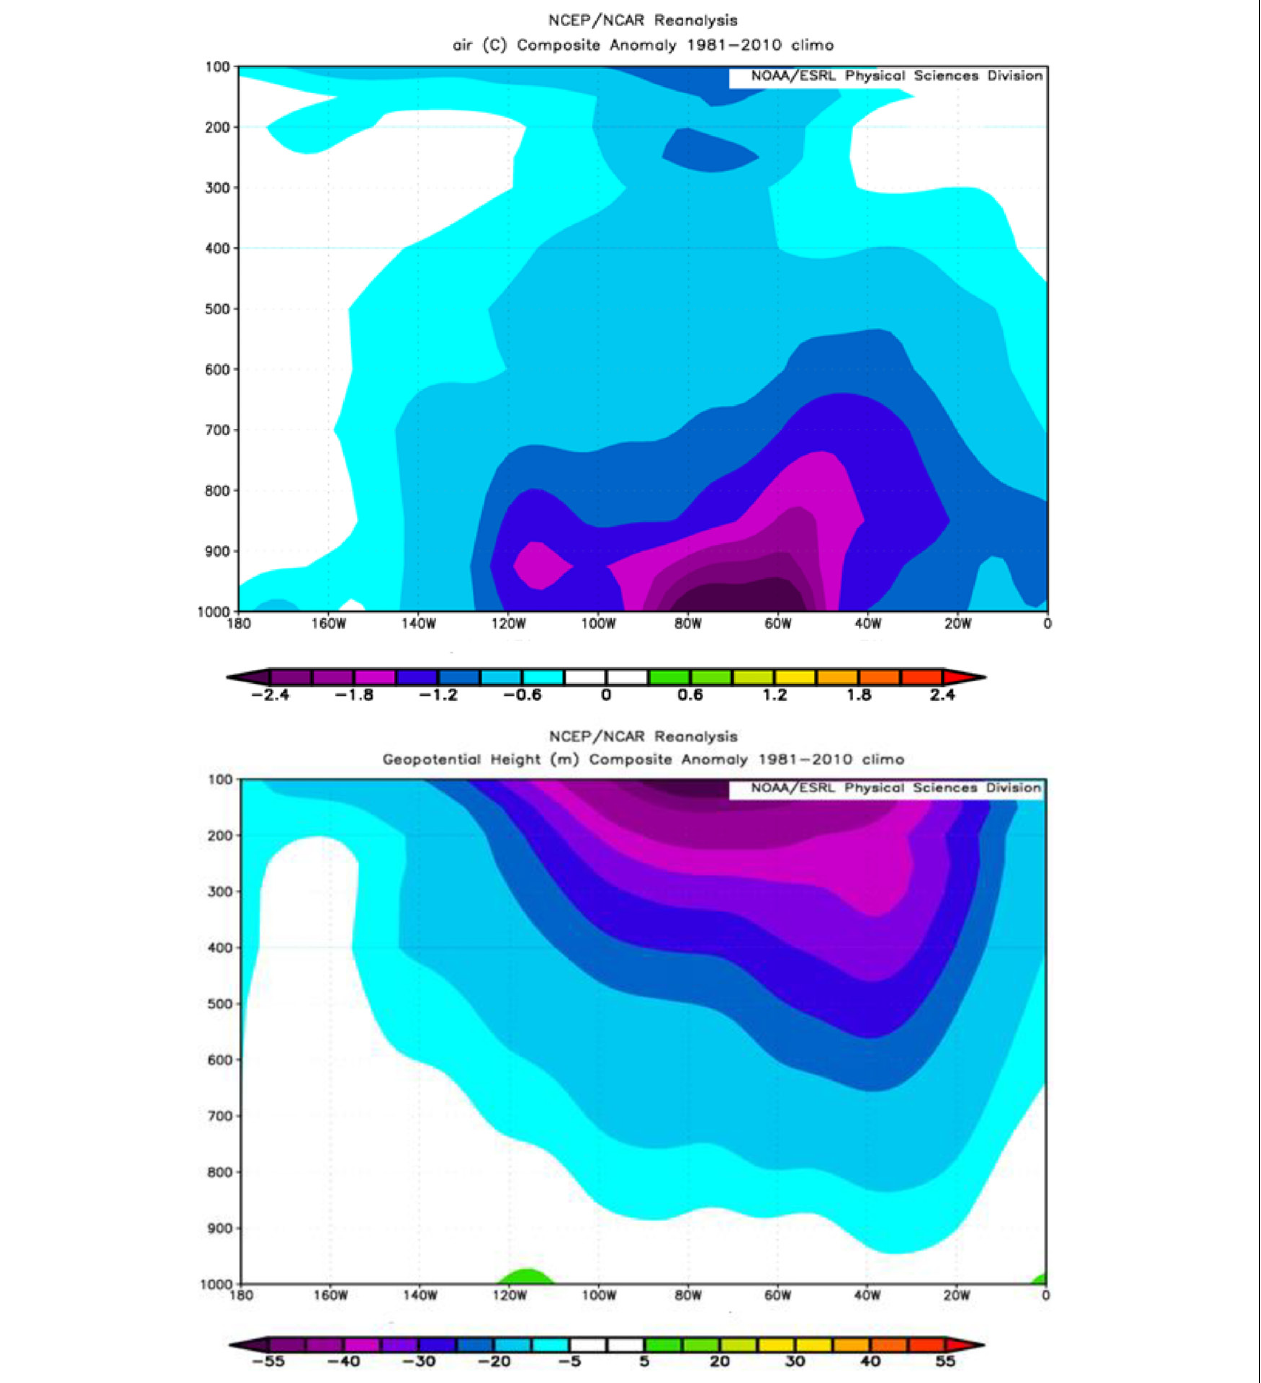
FIGURE 12 | Longitude vs. Height anomaly plot for Dec-Feb, (1979–1996 minus 1999–2017) averaging over 50 ◦ N to 70 ◦ N. Parameter used are air temperature, and geopotential height, respectively, as shown in subtitles. Plots are generated by the NOAA/ESRL Physical Sciences Division, Boulder Colorado from their Web site at: http://www.esrl.noaa.gov/psd/.